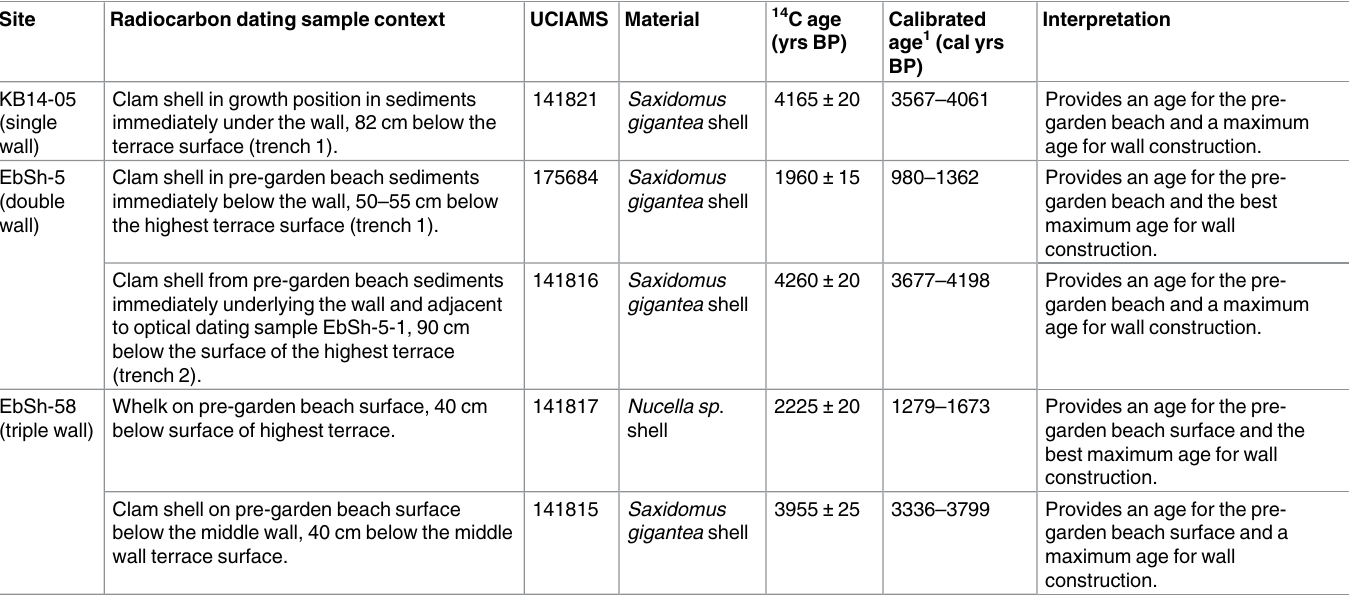
Table 1. Radiocarbon ages from excavations of three clam gardens on Quadra Island, BC